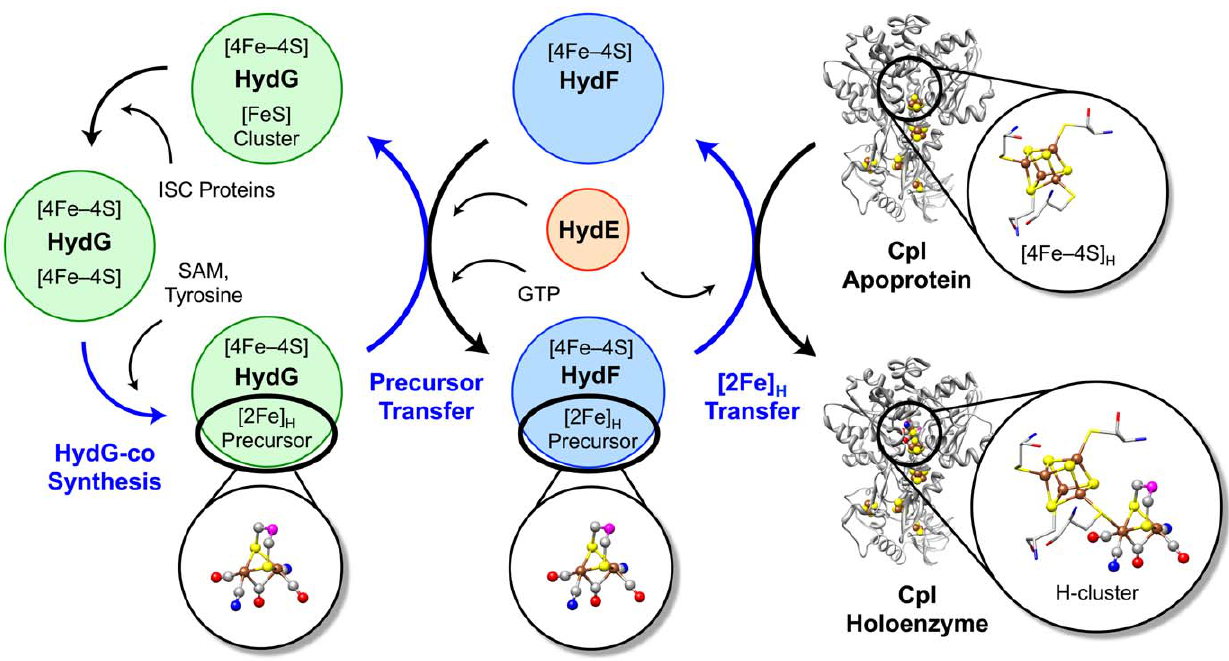
Figure 3. Schematic illustrating the proposed H-cluster biosynthetic pathway and roles of the Hyd maturases for [FeFe] hydrogenase activation. Blue arrows indicate the steps directly associated with the synthesis and translocation of the [2Fe] H subcluster. The H- cluster CO and CN – ligands, and possibly the DTMX bridge, are generated from tyrosine during HydG-catalyzed radical SAM chemistry. These adducts are assembled onto a HydG-bound [4Fe–4S] cluster to form HydG-co, a [2Fe] H subcluster precursor. HydG transfers this precursor to HydF in a process during which HydF-catalyzed GTP hydrolysis may cause a conformational change that facilitates the interaction of HydF with HydG and/or HydE in order to acquire HydG-co. HydF then inserts the [2Fe] H precursor into the hydrogenase apoprotein, resulting in the maturation of active [FeFe] hydrogenase. We hypothesize that by utilizing electrons derived from radical SAM chemistry, HydE assists with [2Fe] H precursor transfer amongst HydG, HydF, and the hydrogenase apoprotein. Following the transfer of HydG-co to HydF, the HydG CTD [4Fe–4S] cluster scaffold is likely reconstituted by the host cell ISC machinery. Ball-and-stick representations of the H-cluster and its precursors are depicted with the following color scheme: Fe, brown; S, yellow; C, gray; O, red; N, blue; unknown atom (X),